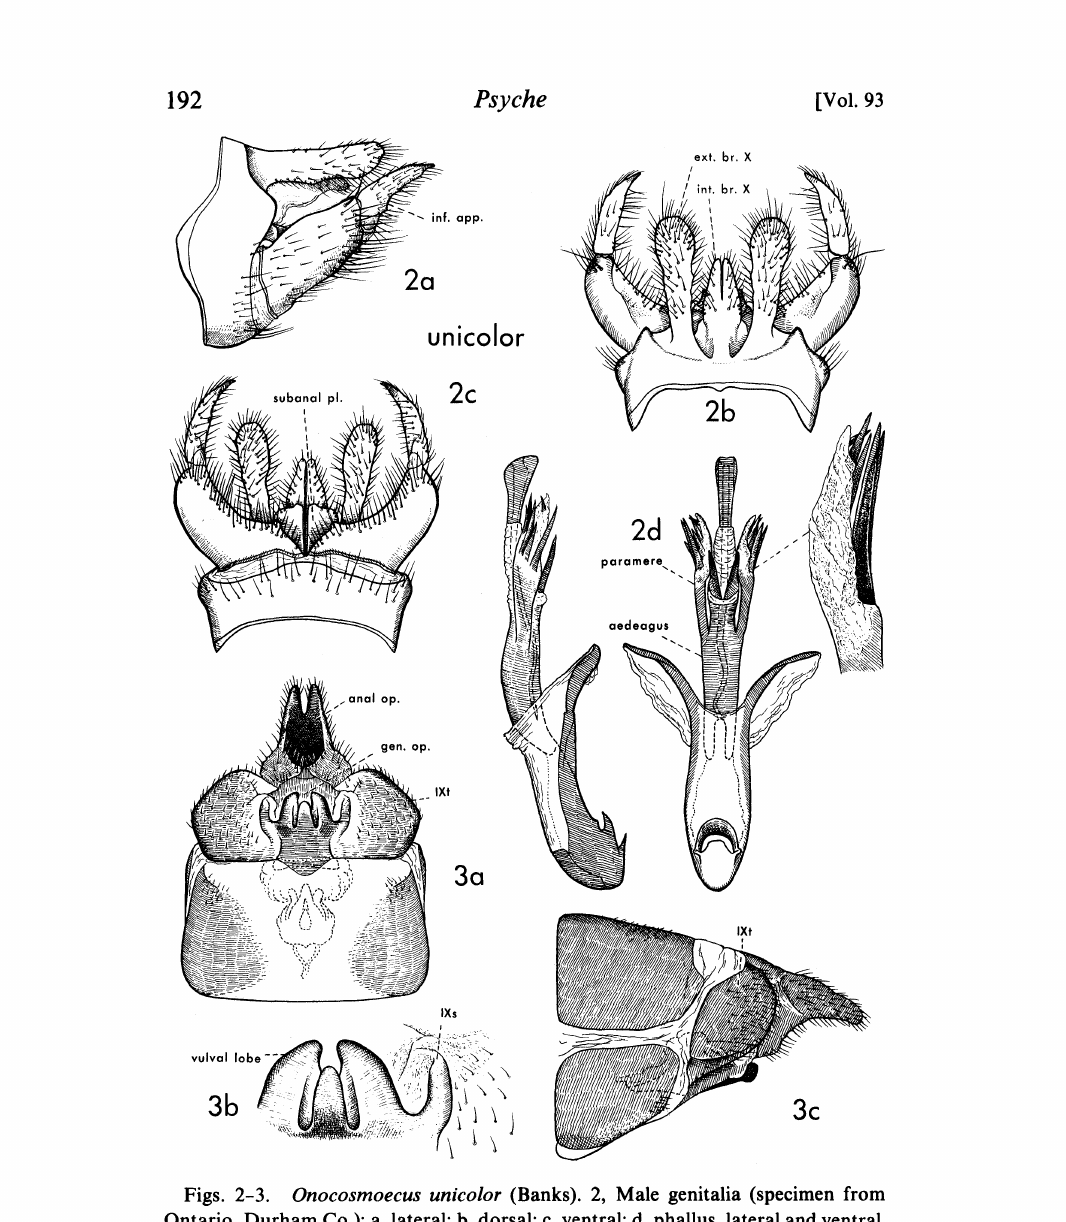
Figs. 2-3. Onocosmoecus unicolor (Banks). 2, Male genitalia (specimen from Ontario, Durham Co.): a, lateral; b, dorsal; c, ventral; d, phallus, lateral and ventral. 3, Female genitalia (specimen from Ontario, Durham Co.): a, ventral; b, detail of vulval lobe; c, lateral. (anal op., anal opening; gen. op., genital opening; IXt & IXs, tergum and sternum of segment IX; inf. app., inferior appendage; ext. br. X, int. br. X, external and internal branches of segment X; subanal pl., subanal